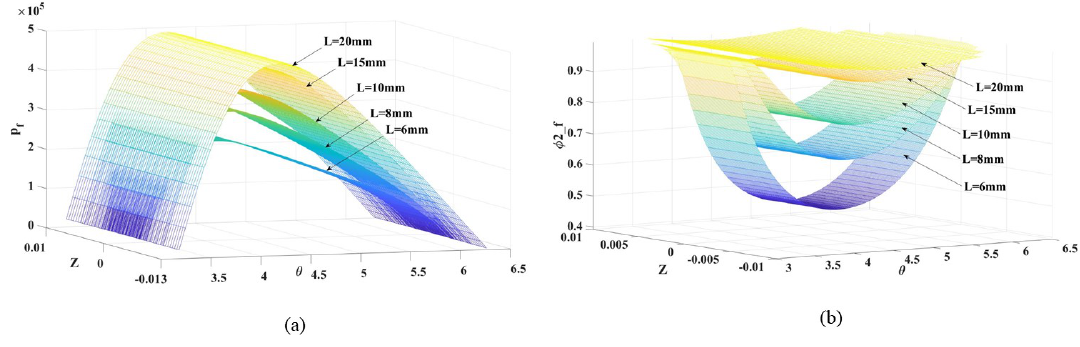
Figure 8. Graph of variation and oil film pressure under finite length bearing. ( a ) Variation of oil film pressure. ( b ) Variation of φ 2_ f .